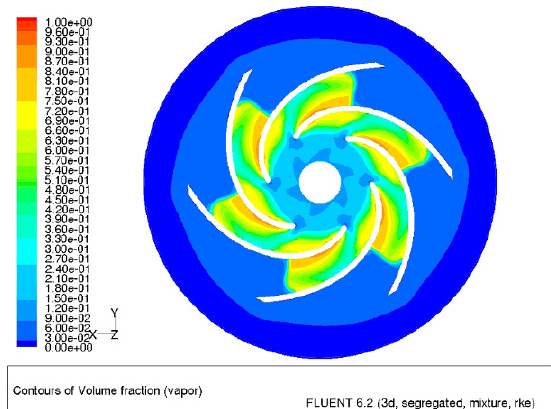
Figure 10. Development of cavitation for impeller E3 (Q - NPSH = 1,3 m. Colours illustrates the fraction of gaseous phase.